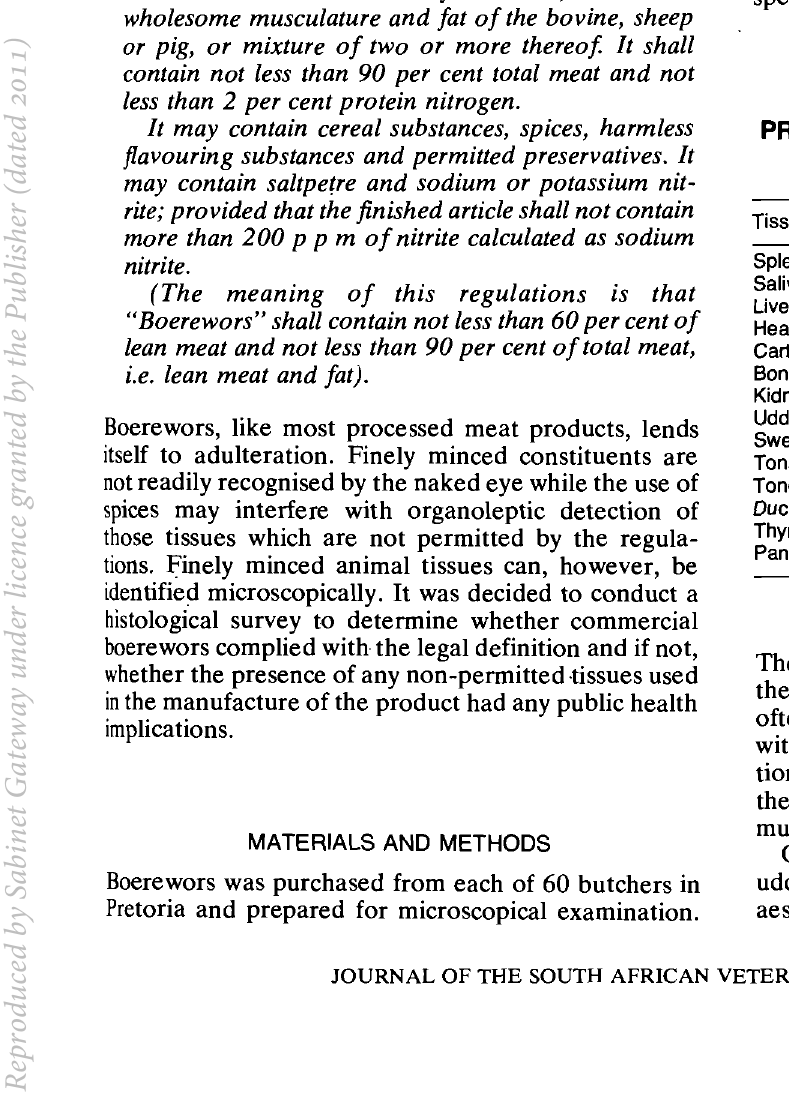
Table 1: FREQUENCY AND DETAILS OF PROHIBITED TISSUES OF ANIMAL ORIGIN IN